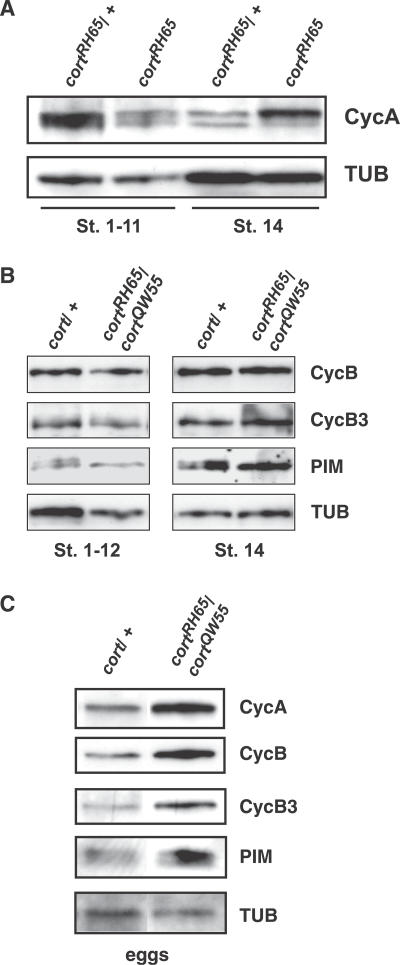
CORT Targets Sequential Degradation of APC/C Substrates in Meiosis(A) Cyclin A levels are elevated in cort mutant stage 14 oocytes. Western blot showing Cyclin A levels in immature stage 1–11 egg chambers and mature stage 14 oocytes from cortRH65/+ or cortRH65 females. The two forms of Cyclin A protein differ by phosphorylation state (L. Vardy, J.A. Pesin, and T.L. Orr-Weaver, unpublished data). The band intensities for each of the proteins were compared as ratios to the signal from tubulin to control for protein loading. By ImageJ analysis, the band intensity of Cyclin A in cortRH65/+ stage 1–11 egg chambers is approximately 1.25-fold greater than Cyclin A in cortRH65 stage 1–11 egg chambers. The band intensity of the more slowly migrating form of Cyclin A in cortRH65 stage 14 oocytes is approximately 2.1-fold greater than the same Cyclin A band in cortRH65/+ stage 14 oocytes. When assessing changes between developmental stages, Cyclin A band intensity in cortRH65/+ stage 1–11 egg chambers is approximately 4.1-fold greater than cortRH65/+ stage 14 oocytes. Cyclin A band intensity in cortRH65 stage 1–11 egg chambers is approximately 2.4-fold greater than cortRH65 stage 14 oocytes. Blot was probed with anti-α-Tubulin as a loading control.(B) Cyclin B, Cyclin B3, and PIM levels are unchanged in cort mutant ovaries. Western blot showing levels of Cyclin B, Cyclin B3, and PIM/Securin in immature stage 1–12 egg chambers and mature stage 14 oocytes from cortRH65/+ or cortRH65/cortQW55 females. A doublet of PIM protein has been noted previously in some strain backgrounds [86]. Blot was probed with anti-α-tubulin as a loading control. All lanes are from the same blot.(C) Cyclin A, Cyclin B, Cyclin B3, and PIM/Securin levels are elevated in eggs laid by cortRH65/cortQW55 females. By ImageJ analysis, band intensities are greater by the following approximate folds in cortRH65/cortQW55 compared to heterozygous controls: Cyclin A, 1.7; Cyclin B, 2.4; Cyclin B3, 2.3; and PIM, 1.7. Western blot was probed with anti-α-Tubulin as a loading control. Nonconsecutive lanes from the same blot are shown.